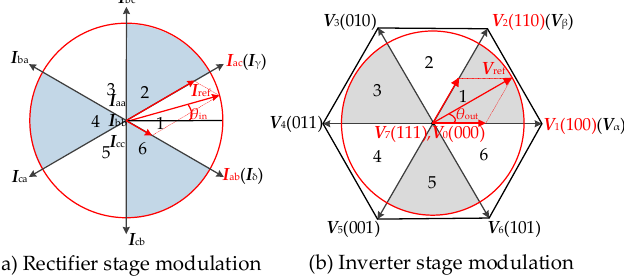
Figure 4. Space Vector Modulation Principle of IMC.